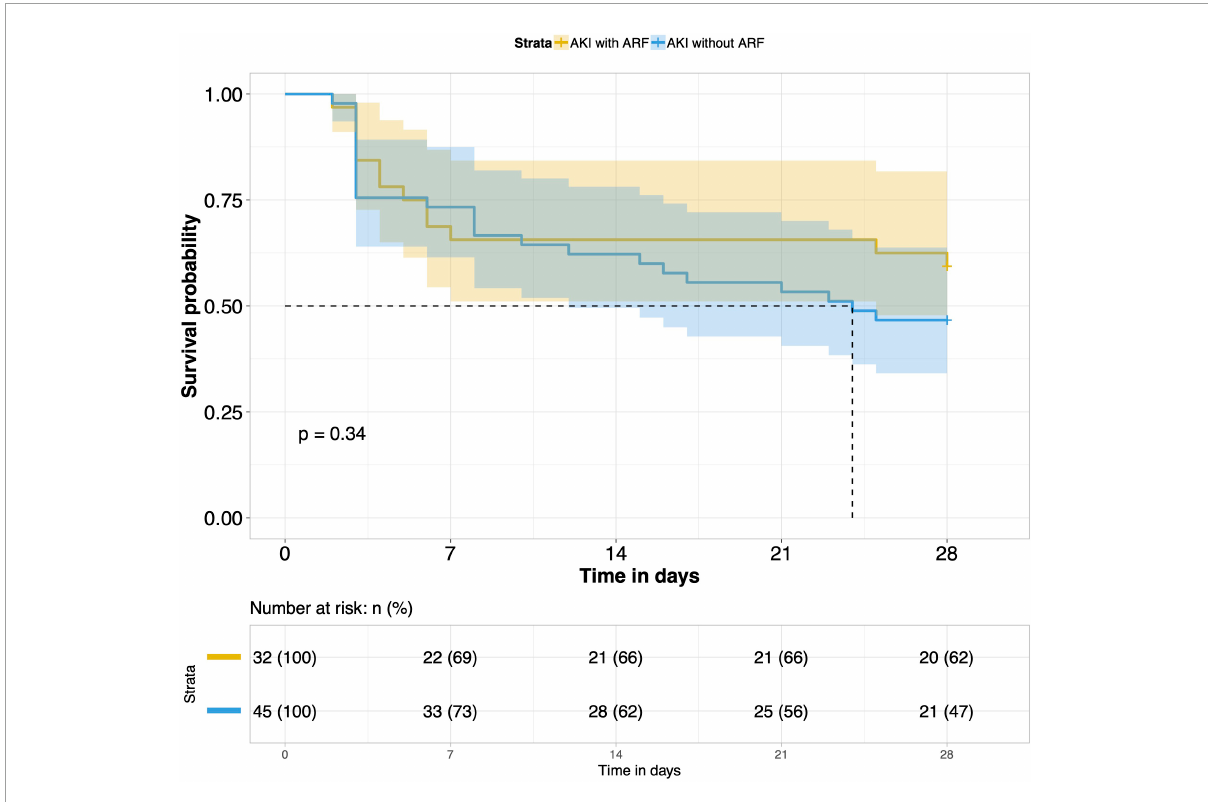
FIGURE8 Survival analysis of AKI with ARF group and AKI without ARF